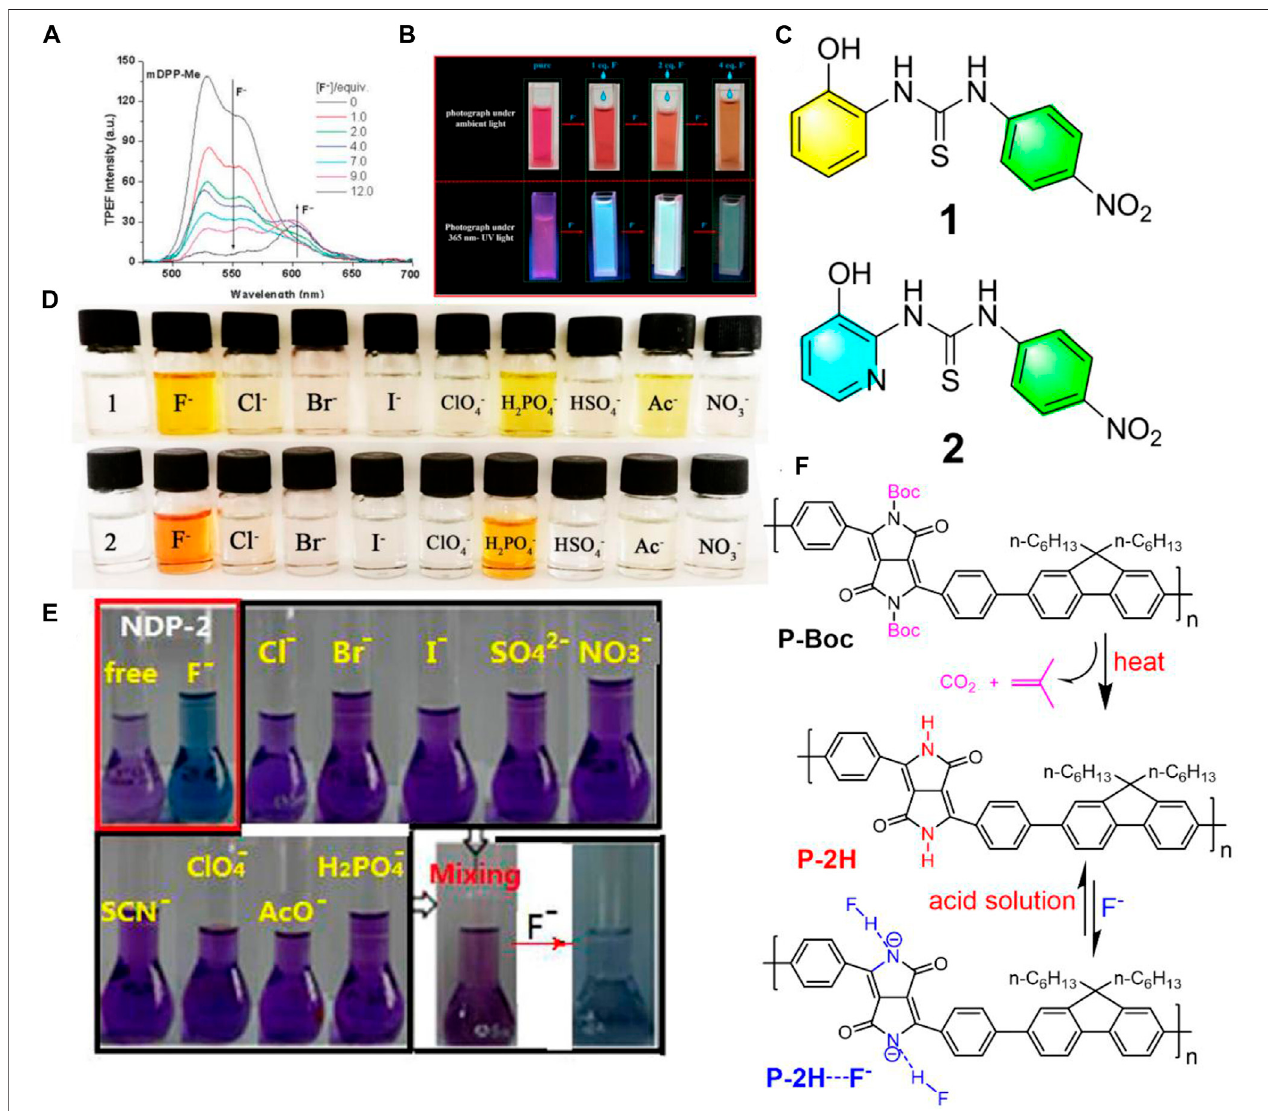
FIGURE 1 | (A) Two-photon excitation fl uorescence spectra of mDPP in THF (1.0 × 10 − 4 M) with different equivalents of fl uoride ions excited at 720 nm under an input laser power of 150 mW (Yang et al., 2013); (B) photographs of IDTI solutions with or without additional different eq. Fluoride anions under ambient light or 365 nm UV light (Yuan et al., 2020); (C) chemical structures of the fl uoride chromogenic sensors of 1 and 2; (D) color changes of the sensors in DMSO (2.0 × 10 − 4 mol/L) by the addition of50equiv.ofdifferentanions(1.0 × 10 − 2 mol/L),respectively (Cao et al.,2020); (E) photographsofnaphthodipyrrolidoneinTHFsolutionbeforeand after the addition of8equiv. ofdifferent anions under ambient light(Sun et al., 2017); (F) chemical structuresofP-Boc and P-2H, and theschematicdiagram ofP-2H sensing fl uoride anions (Zhang et al., 2018).